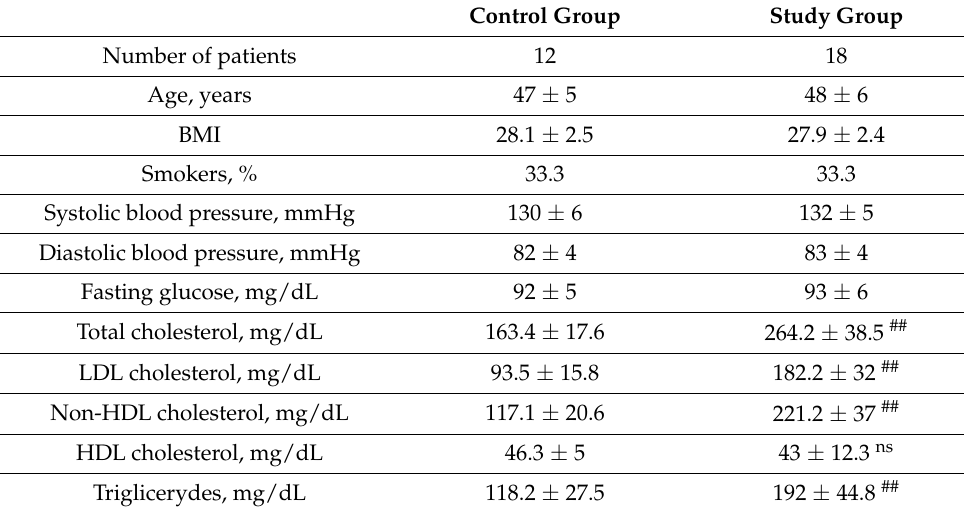
Table 1. Baseline characteristics of patients (values are mean ± SD unless indicated otherwise; (##— p < 0.001 versus control; ns—not statistically significant).